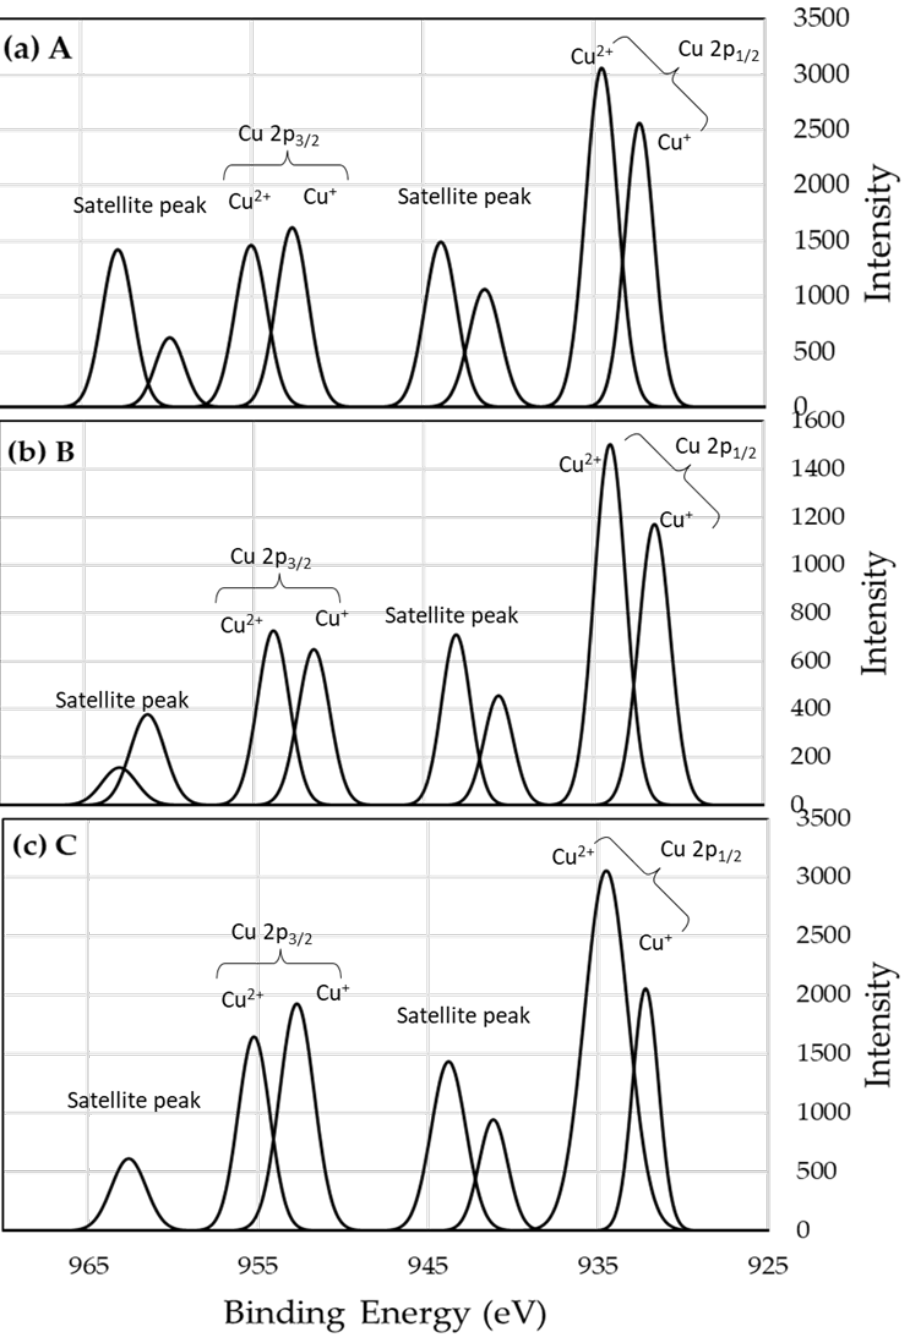
Figure 5. Representative XPS spectra of the porous Cu electrodes from groups ( a ) A, ( b ) B, and ( c ) C, electrodeposited with 3 A/cm 2 for 40 sec, following the CO2RR experiments.